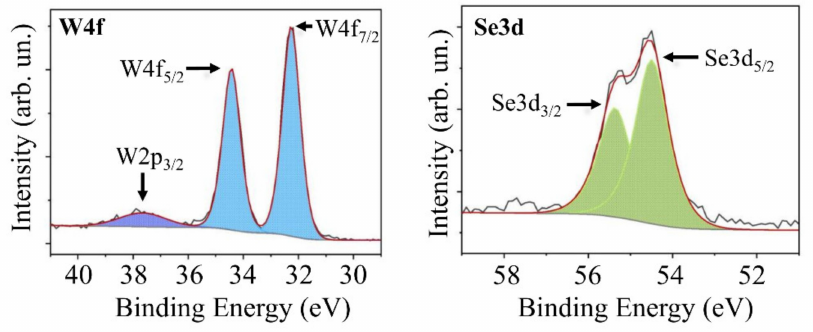
Figure 5. Core level XPS W4f and Se3d spectra of the WSe 2 film obtained by off-axis